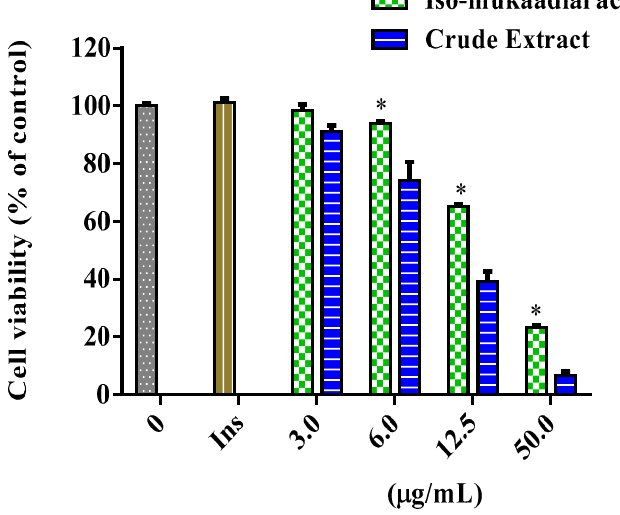
Figure 2. Cytotoxicity of L6 cells after 48-h treatment with iso-mukaadial acetate and crude extract. Cytotoxicity was determined using crystal violet and data expressed as a percentage of the untreated control, * p < 0.05.